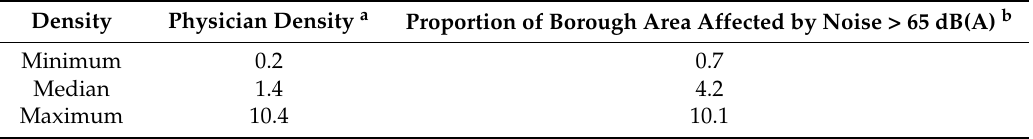
Table 3. Physician density and proportion of borough area affected by noise > 65 dB(A), Hamburg, Germany. Density Physician Density a Proportion of Borough Area Affected by Noise > 65 dB(A) b Minimum 0.2 0.7 1.4